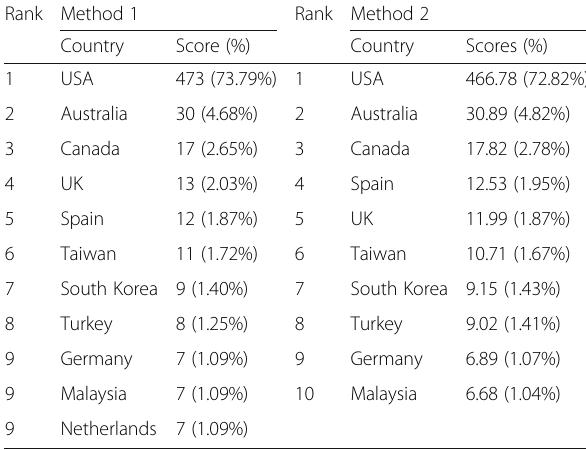
Table 5 Top 10 authorship countries/regions for